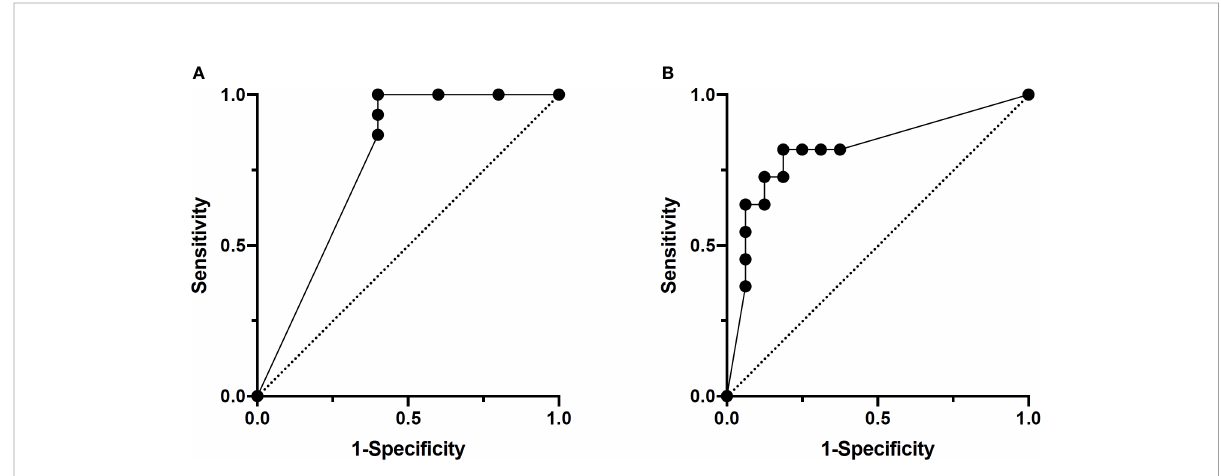
FIGURE 2 ROC curves of per-patient analysis. (A) Lymph node study. AUC: 0.79. (B) Margin study. AUC: 0.85.